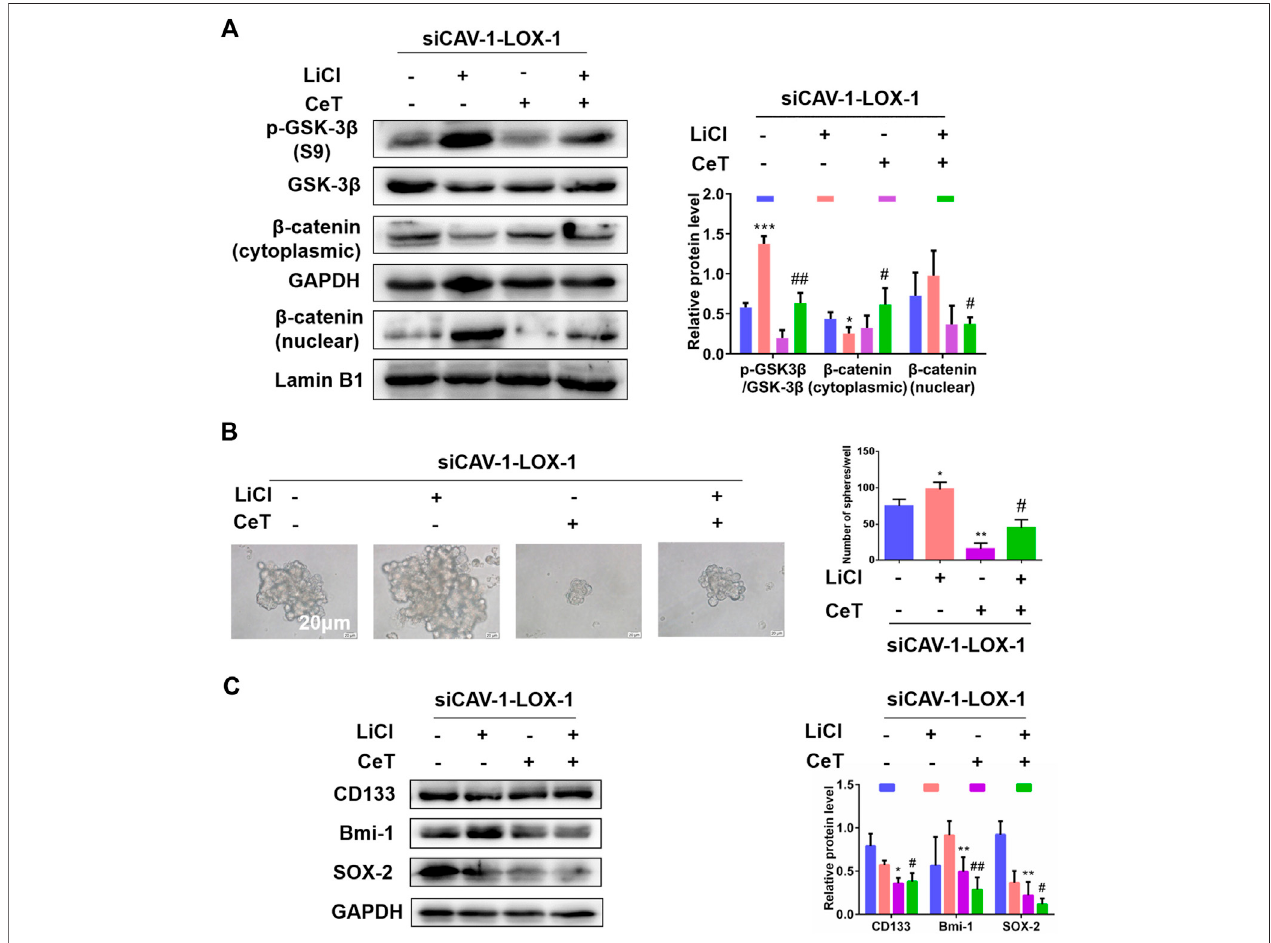
FIGURE 7 | Wnt/ β -catenin pathway was involved in stemness and lipid accumulation mediated by celastrol (A) In the absence and presence of LiCl, the protein levels of p -GSK-3 β (S9), GSK-3 β , β -catenin were examined by western blotting (B) Sphere formation capacity was measured by sphere formation assay. Scale bar: 20 µm (C) The expression of stemness related proteins was detected by western blotting. The data were shown as the mean ± SD of three replicates. * p < 0.05, ** p < 0.01, *** p < 0.001 vs. the control group; # p < 0.05, ## p < 0.01 vs. siCAV-1-LOX-1 cells treated with LiCl.